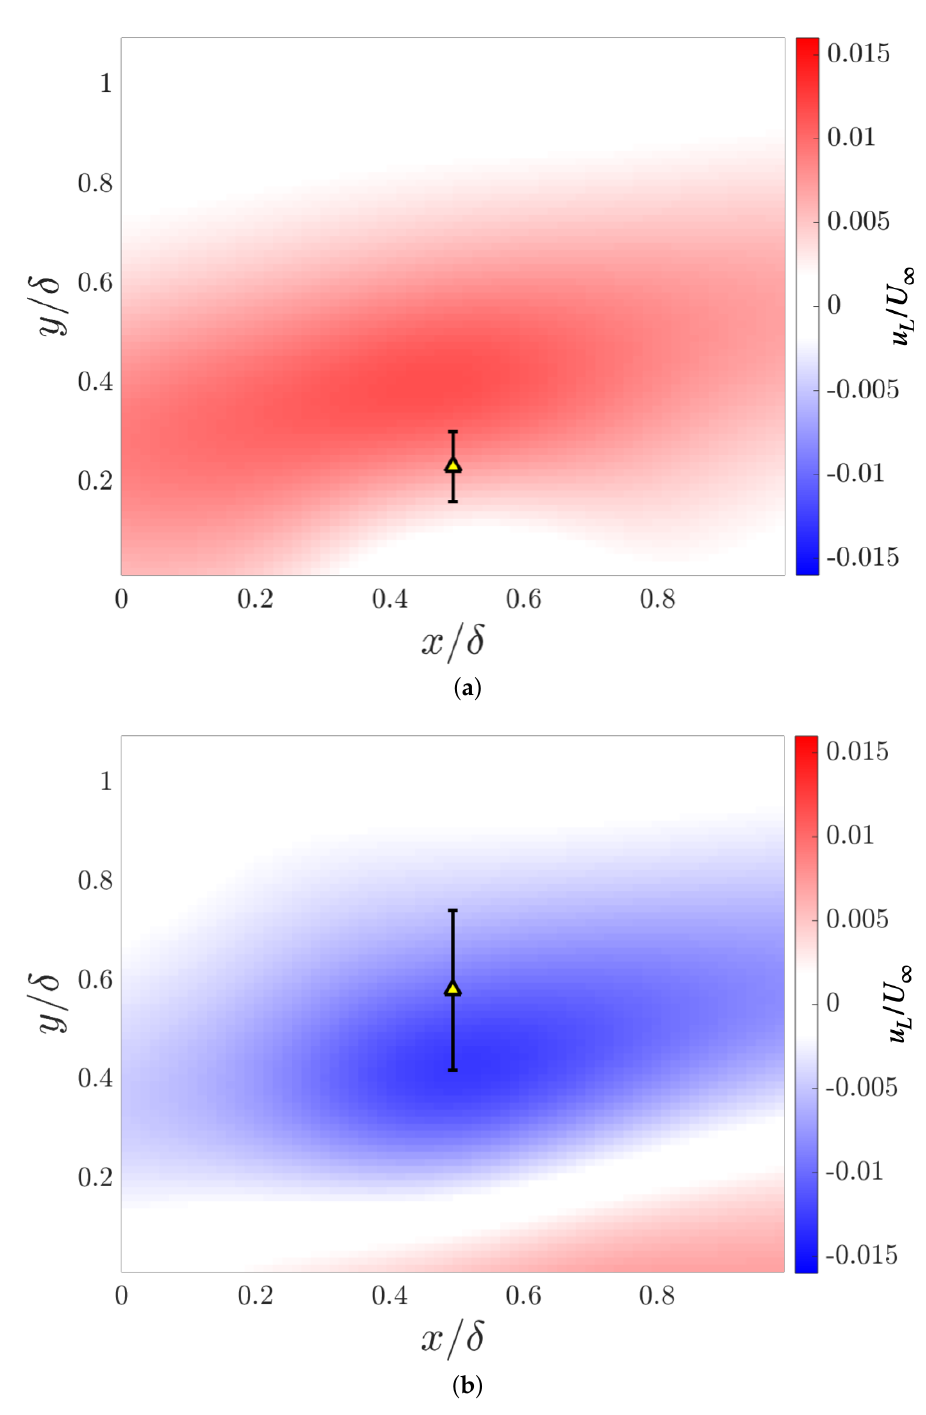
Figure 4. Conditionally averaged fluctuating large-scale velocity fields based on the height of small-scale vortices. ( a ) shows the conditionally averaged fluctuating large-scale velocity field for ¯ y vortex = 0.23 δ while ( b ) shows the conditionally averaged fluctuating large-scale velocity field for ¯ y vortex = 0.58 δ . The yellow triangle indicates the mean position of the small-scale vortices while the error-bar shows the standard deviation in the heights of the vortices